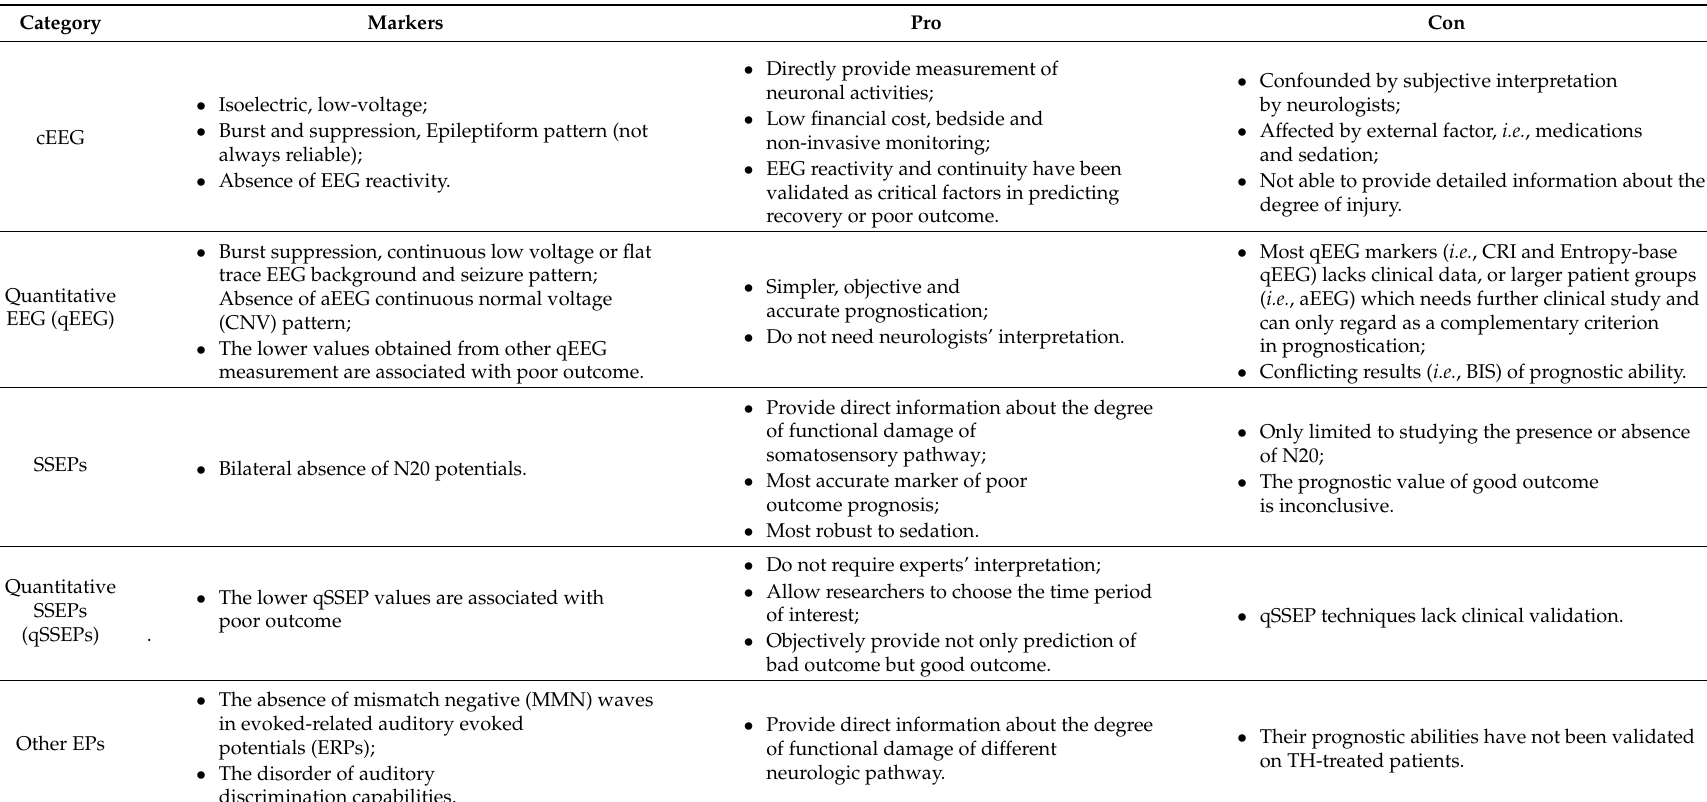
Table 2. Electrophysiological markers with pros and cons for use in